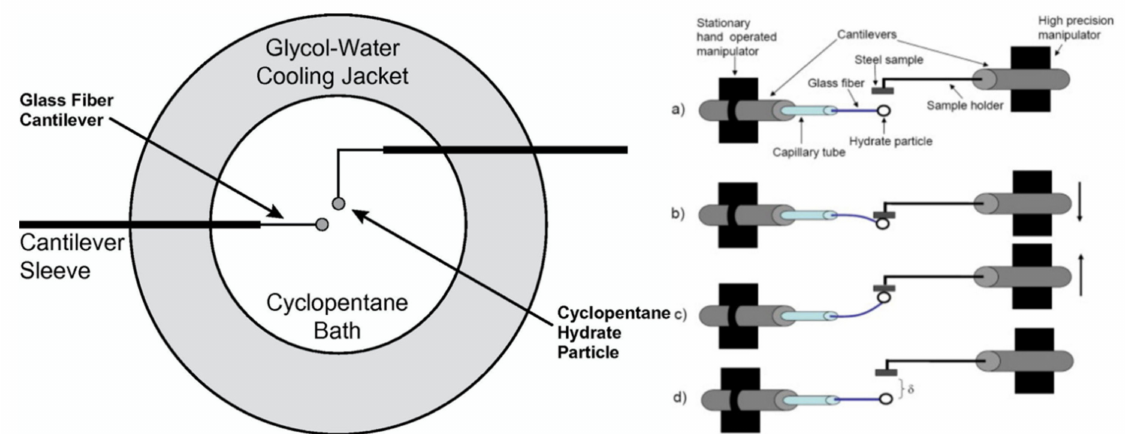
Figure 1. ( Left ) Schematic diagram of the top view of a cell of the micromechanical force (MMF) apparatus. ( Right ) Working mechanism of the MMF: The cantilever placed at the left is hand operated and holds the hydrate particle, whereas the right-hand one, where the solid substrate is placed, is highly precise. ( a ) Initial position of the cantilevers. ( b ) By moving down the precise cantilever, a preload can be applied to the hydrate particle, ( c ) the precise cantilever can be moved back until the particle is removed from the solid surface, and ( d ) the required distance ( δ ) to remove the particle from the solid sample can be registered. Following Hook’s law, the distance is multiplied to the spring constant of the cantilever to obtain the force of adhesion. Reprinted with permission from ref. [68]. © 2021 Elsevier ( left ) and reprinted with permission from ref. [65]. © 2021 Elsevier ( right